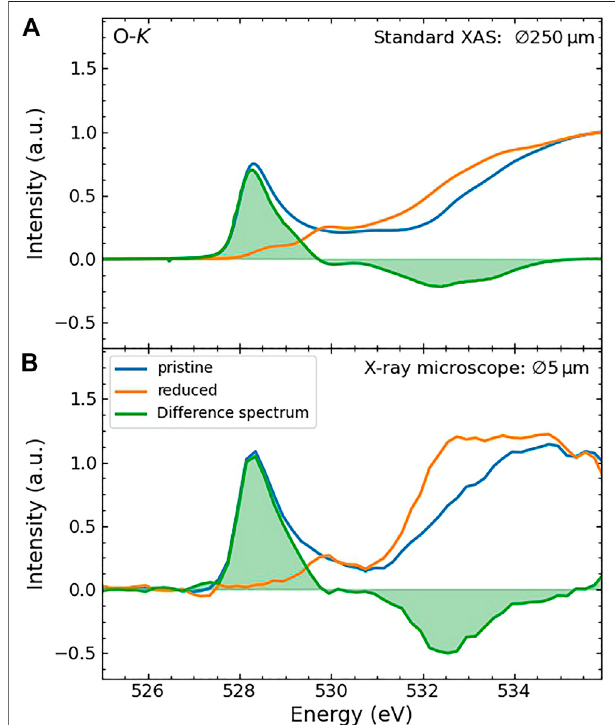
FIGURE 3 | Oxygen K -edge XAS measurements for both the pristine and reduced PrNiO 3 thin fi lm in a standard experimental setup (A) and at the x-ray microscope (B) . The spectral weight around 528 eV ( “ pre-peak ” ) vanishes upon reduction, in agreement with previous studies.